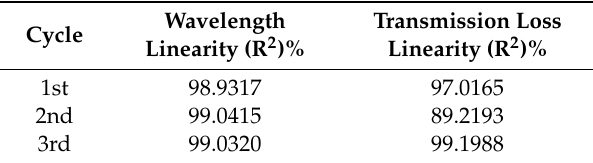
Table 3. Linearity of wavelength shift and transmission loss over three temperature cycles under LPFG (D = 65 µ m, Λ = 620 µ m).